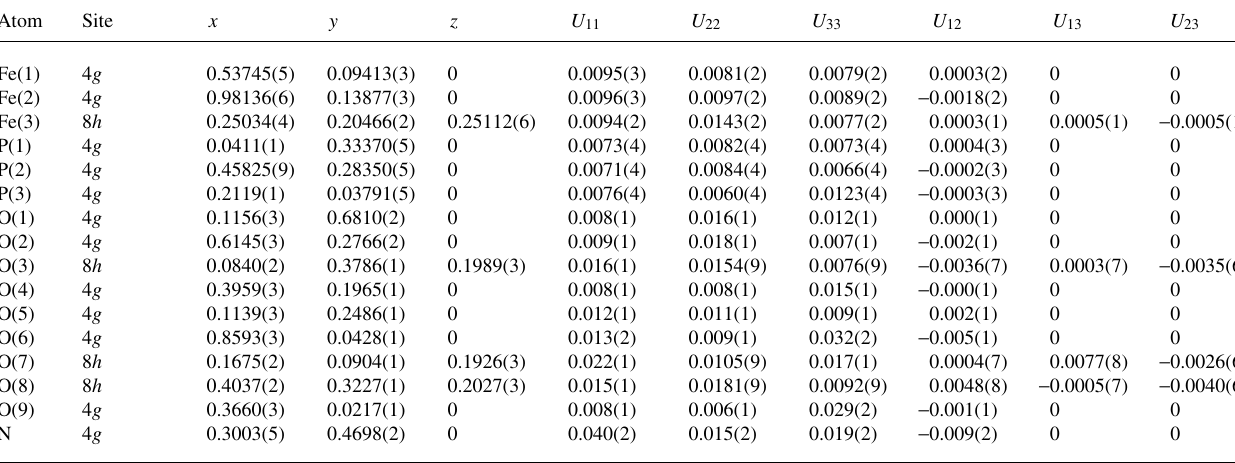
Table 3. Atomic coordinates and displacement parameters (in Å 2 ) .